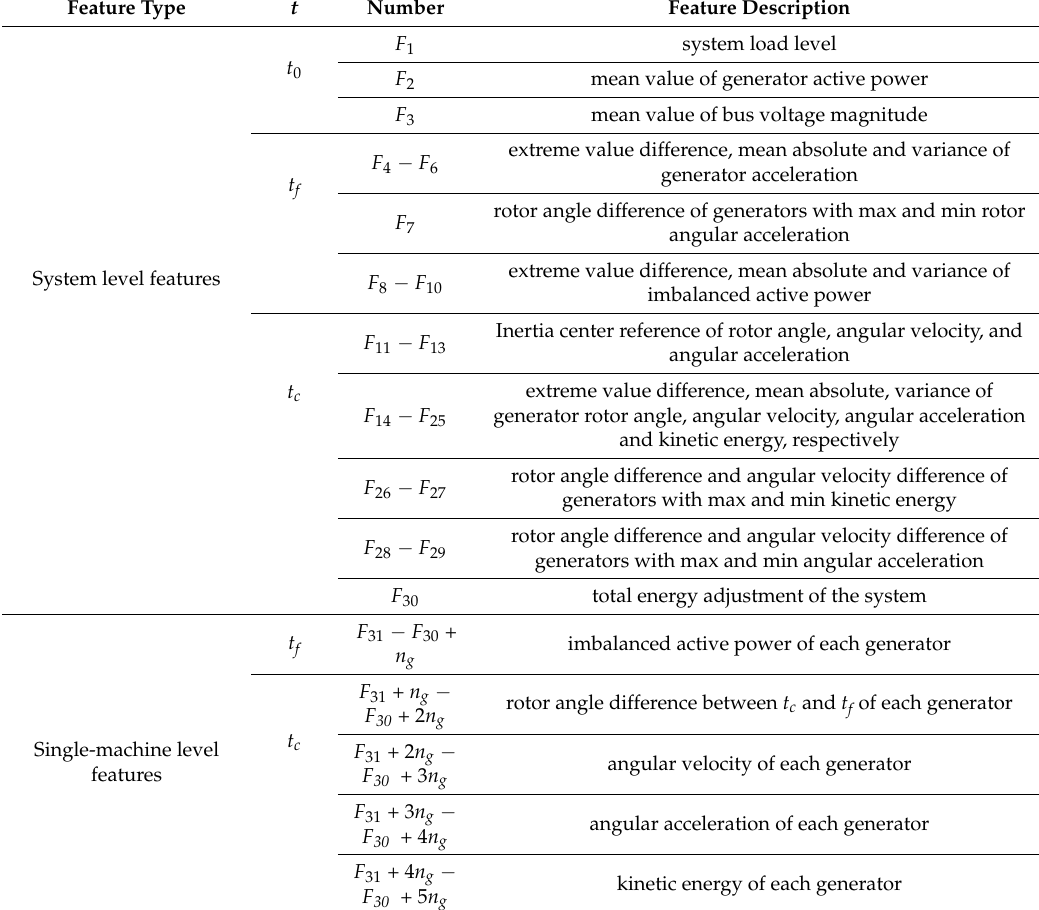
Table 2. Initial feature